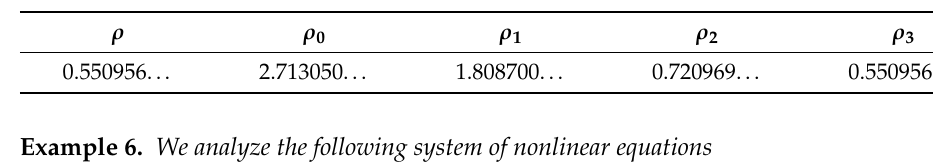
Table 5. Radius for Example